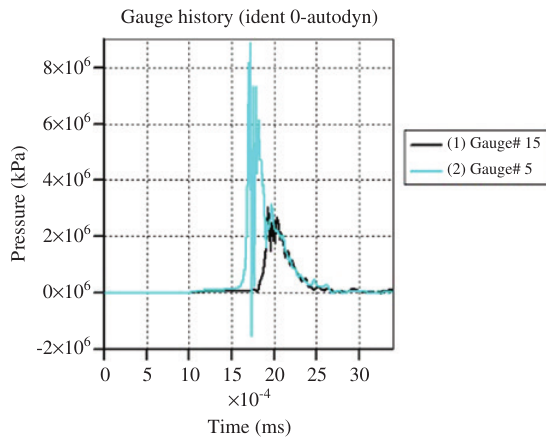
Figure 9: Pressure profiles of combination in flyer and base